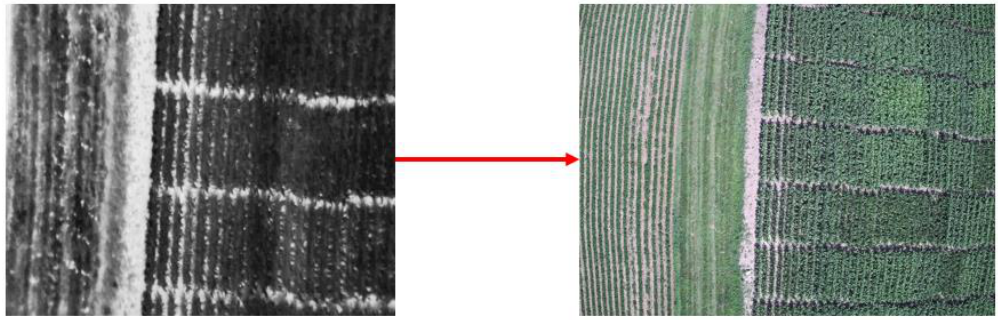
Figure 12. Sample corresponding thermal and RGB images from the FLIR Duo Pro R.